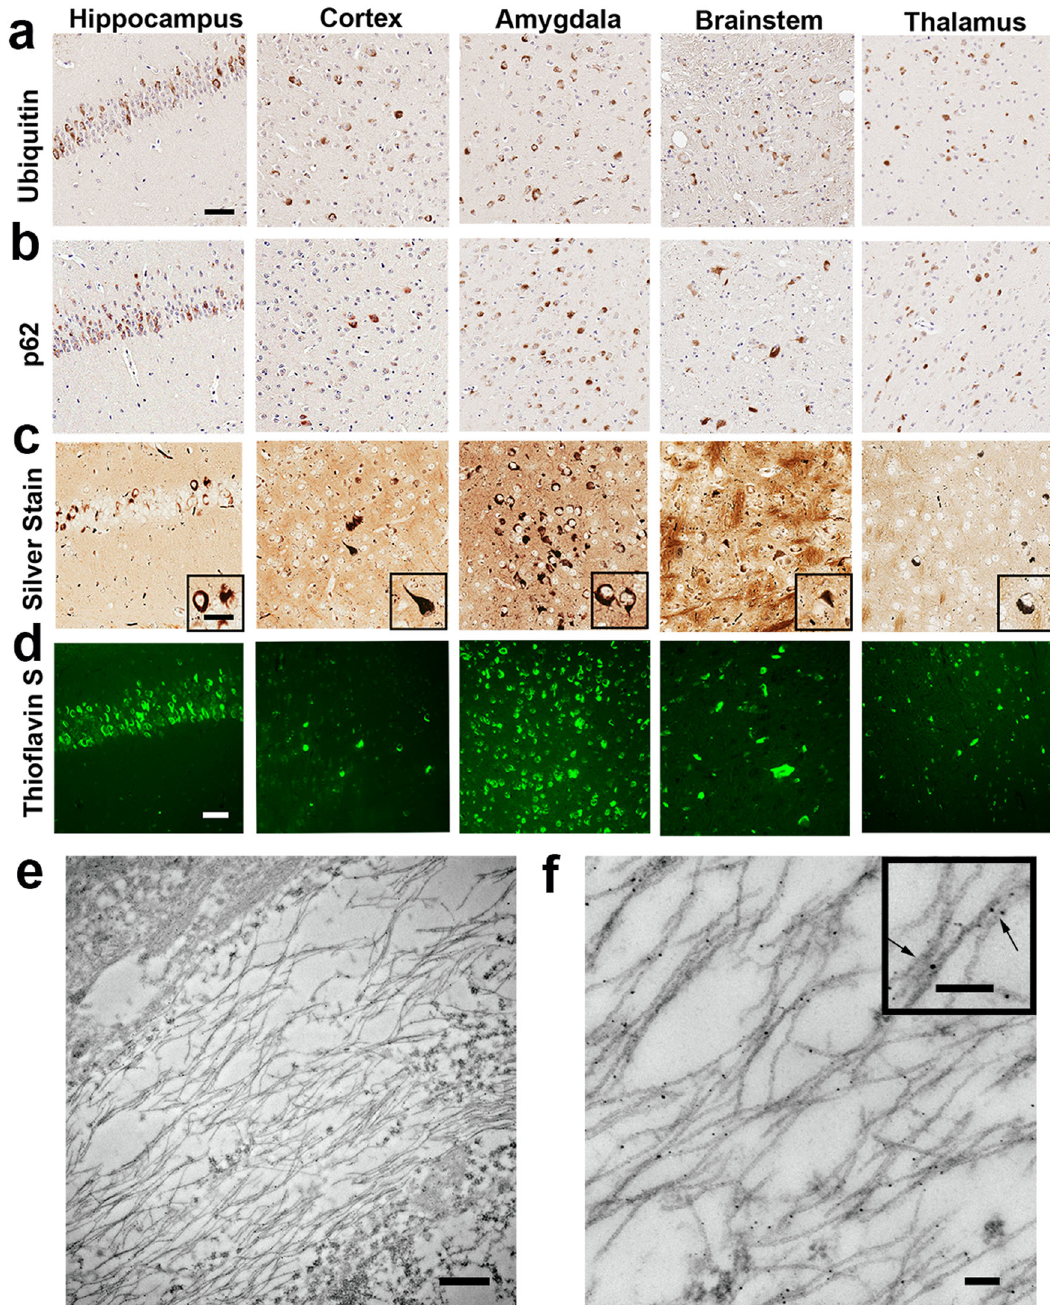
Fig. 5 Histological and ultrastructural characterization of tau SPAM mice pathological tau inclusions. IHC staining of tau pathological inclusions with ( a ) anti-ubiquitin and ( b ) anti-p62/sequestosome-1. In 6-month-old tau SPAM mice, tau inclusions were also ( c ) argyophillic as stained with Campbell – Switzer silver stain and ( d ) readily labeled with Thio fl avin S. Scale bars are 50 μ m for main image and 25 μ m for inset. e Immuno-EM analysis revealed that tau aggregates are composed of ultrastructural tau fi laments as detected and labeled with 3026 antibody against total tau. Scale bar = 500 nm. f Magni fi ed image shows pathogenic tau within straight fi lamentous structures. Scale bar = 100 nm for main image and